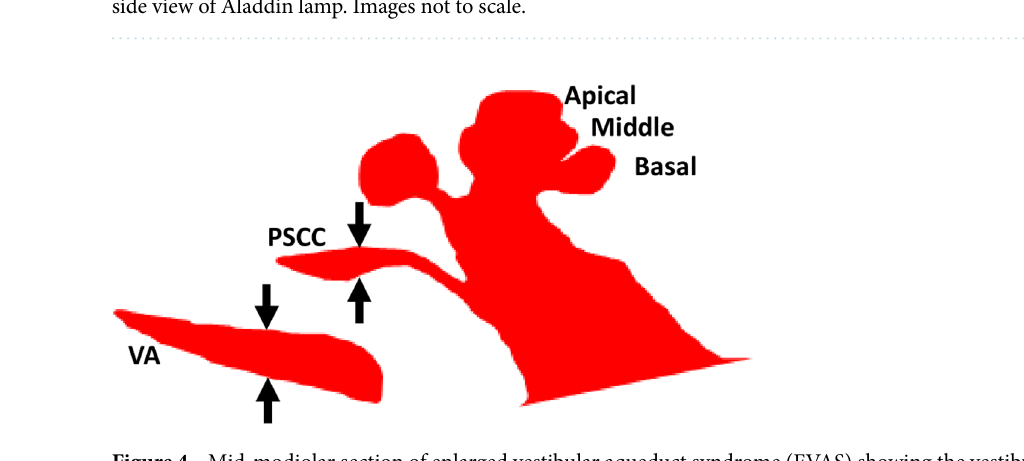
Figure 3. Mid-modiolar section of the cochlear portion of the normal anatomy (NA) inner ear resembles the side view of Aladdin lamp. Images not to scale.